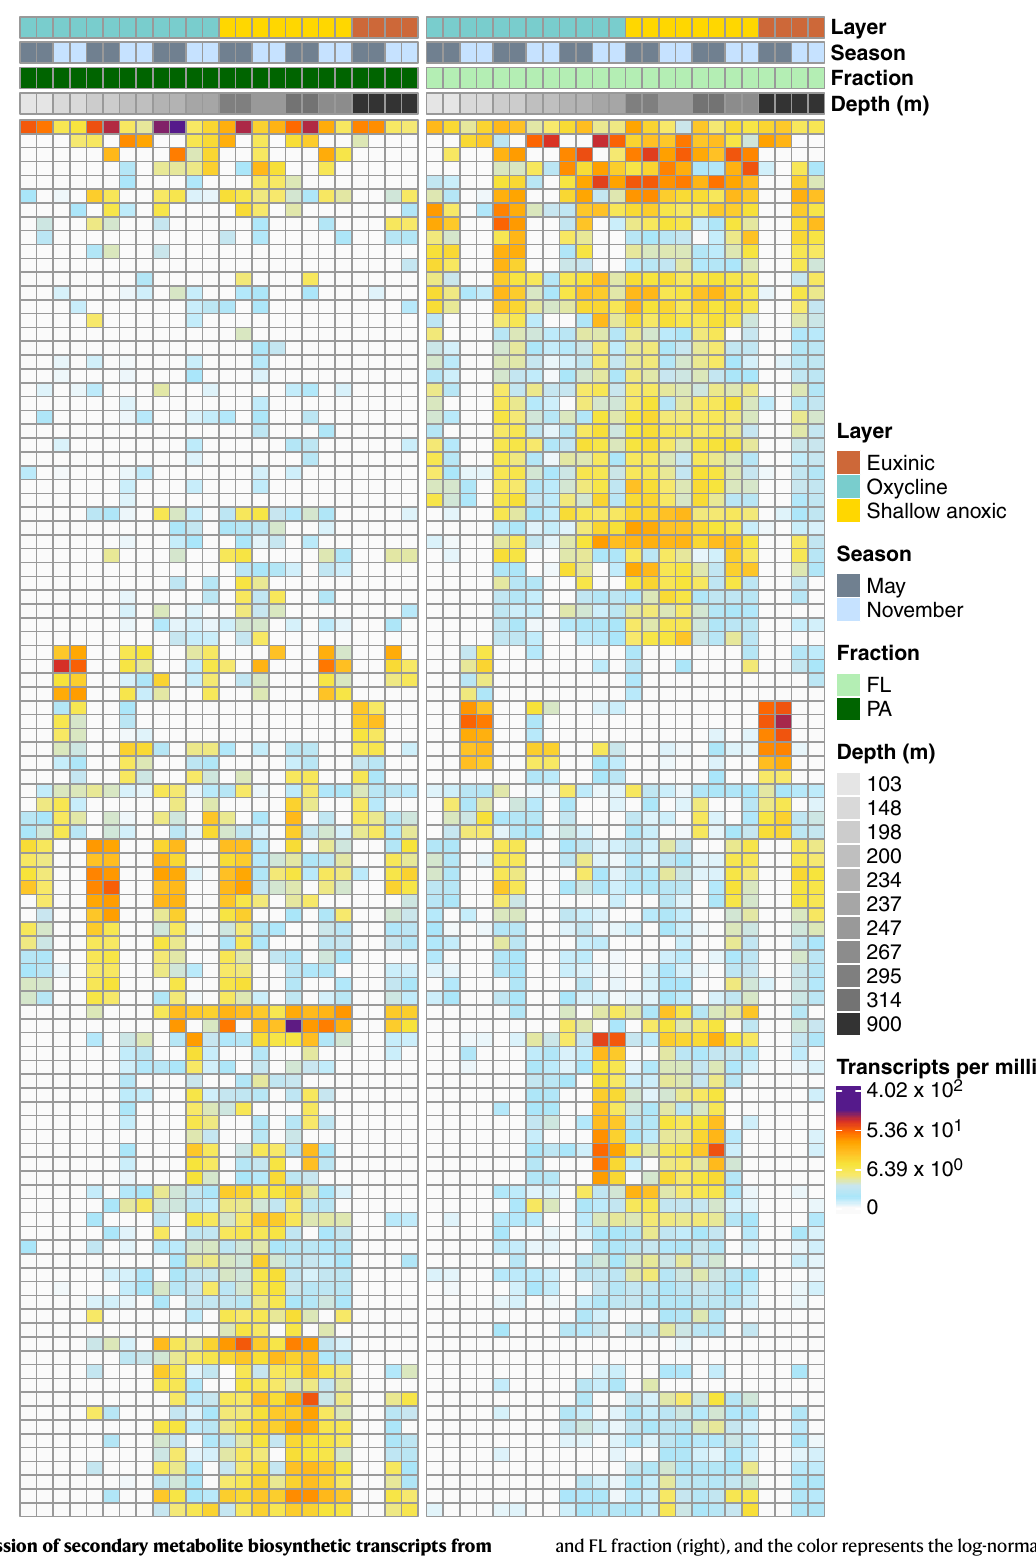
and FLfraction (right),and the colorrepresents the log-normalizedtranscripts per million. Source data are provided as a Source Data fi